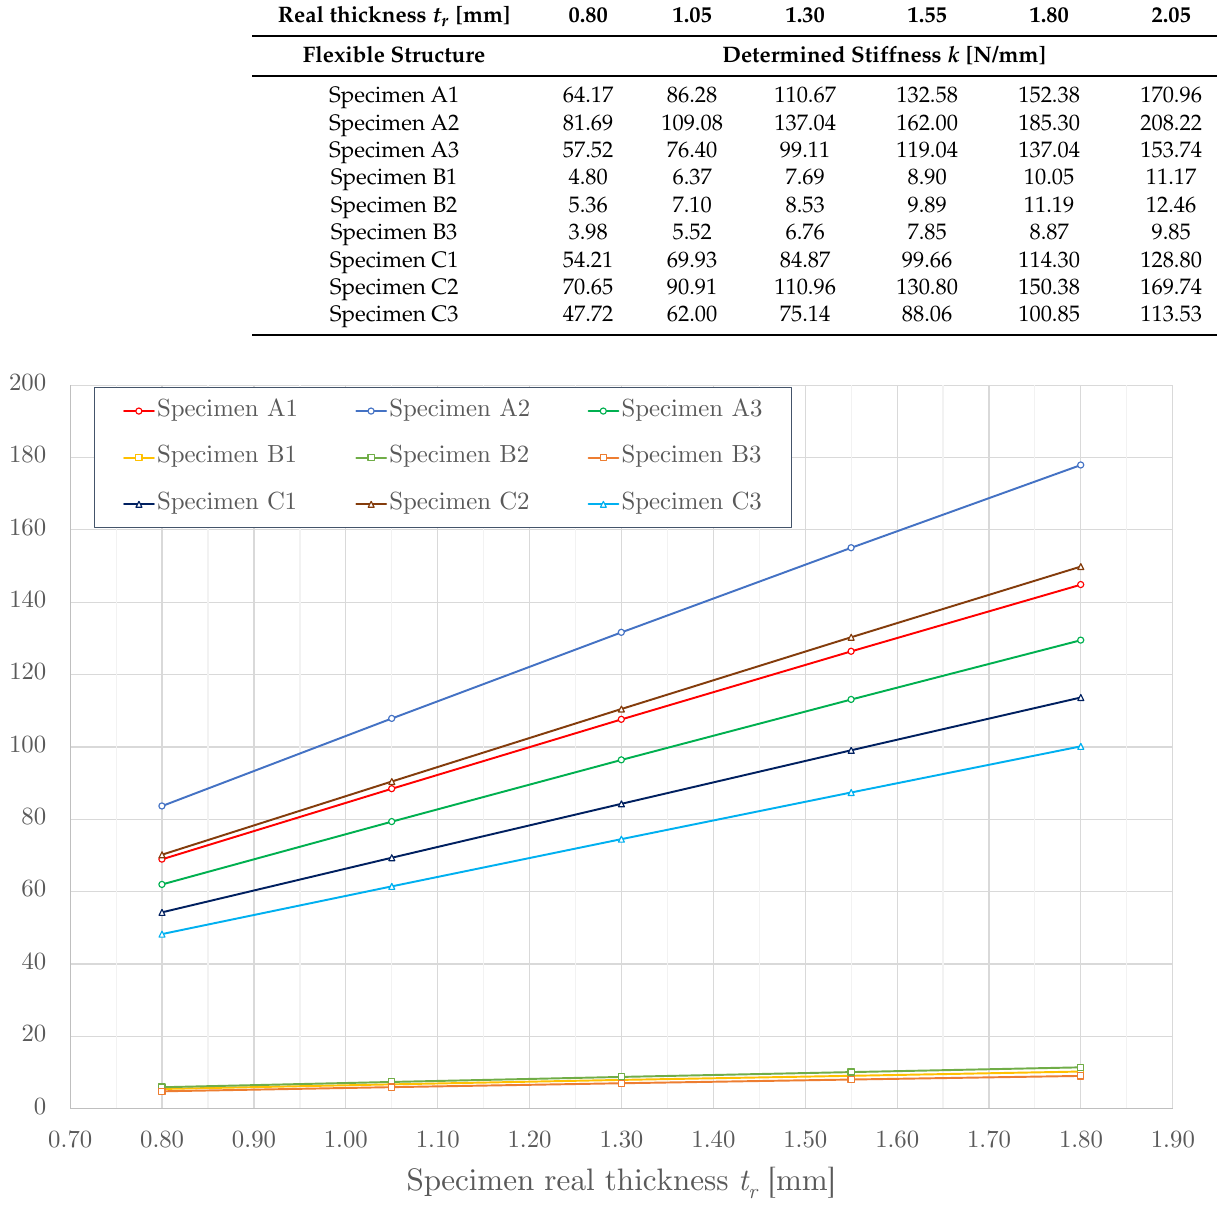
Table 7. Evaluation of stiffness from parametric study.